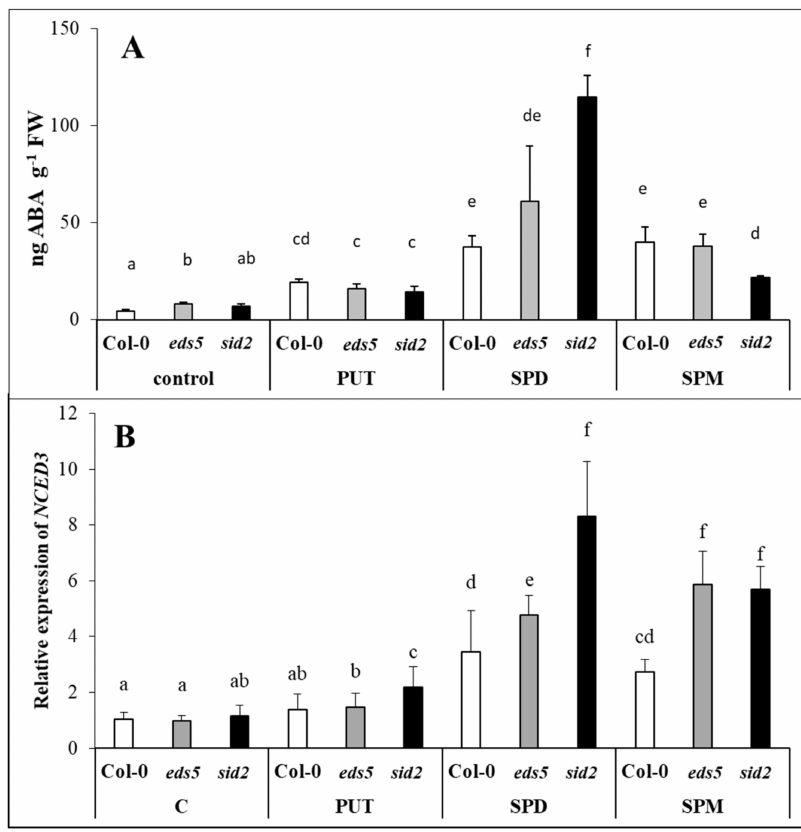
Figure 8. E ff ect of 0.5 mM 1-day of putrescine (PUT), spermidine (SPD) and spermine (SPM) treatments on the content of abscisic acid (( A ) ABA) and the expression level of gene involved in abscisic acid synthesis (( B ) NCED3: 9-cis-epoxycarotenoid dioxygenase3) in Col-0, wild type, eds5-1 ( eds5 ) and sid2-2 ( sid2 ) Arabidopsis mutants. Data represent mean values ± SD. Di ff erent letters indicate significant di ff erences at p ≤ 0.05